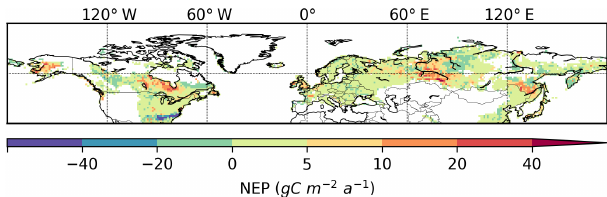
Figure 11. Simulated annual net ecosystem production (NEP), av- eraged over 1901–2009. Obtained by multiplying peatland NEP (gCm − 2 peatlanda − 1 ) with peatland fraction for each grid